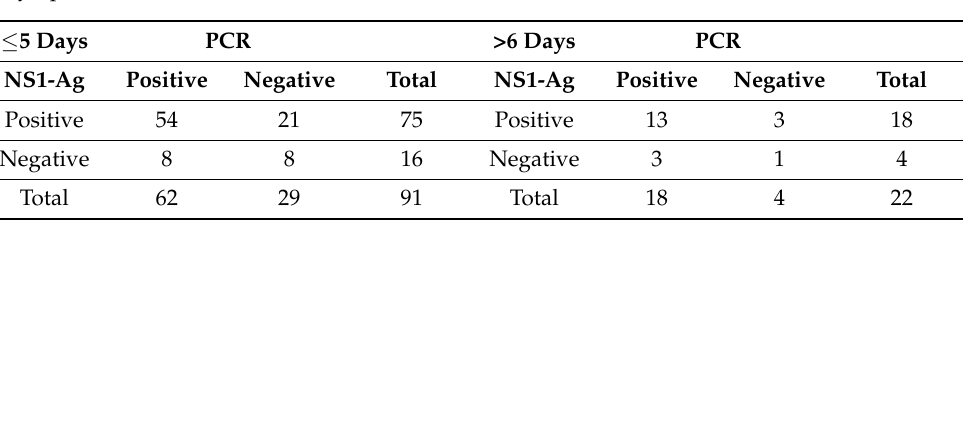
Table 3. Results of samples tested by DENV-NS1-Ag positive test compared to RT-PCR by days of